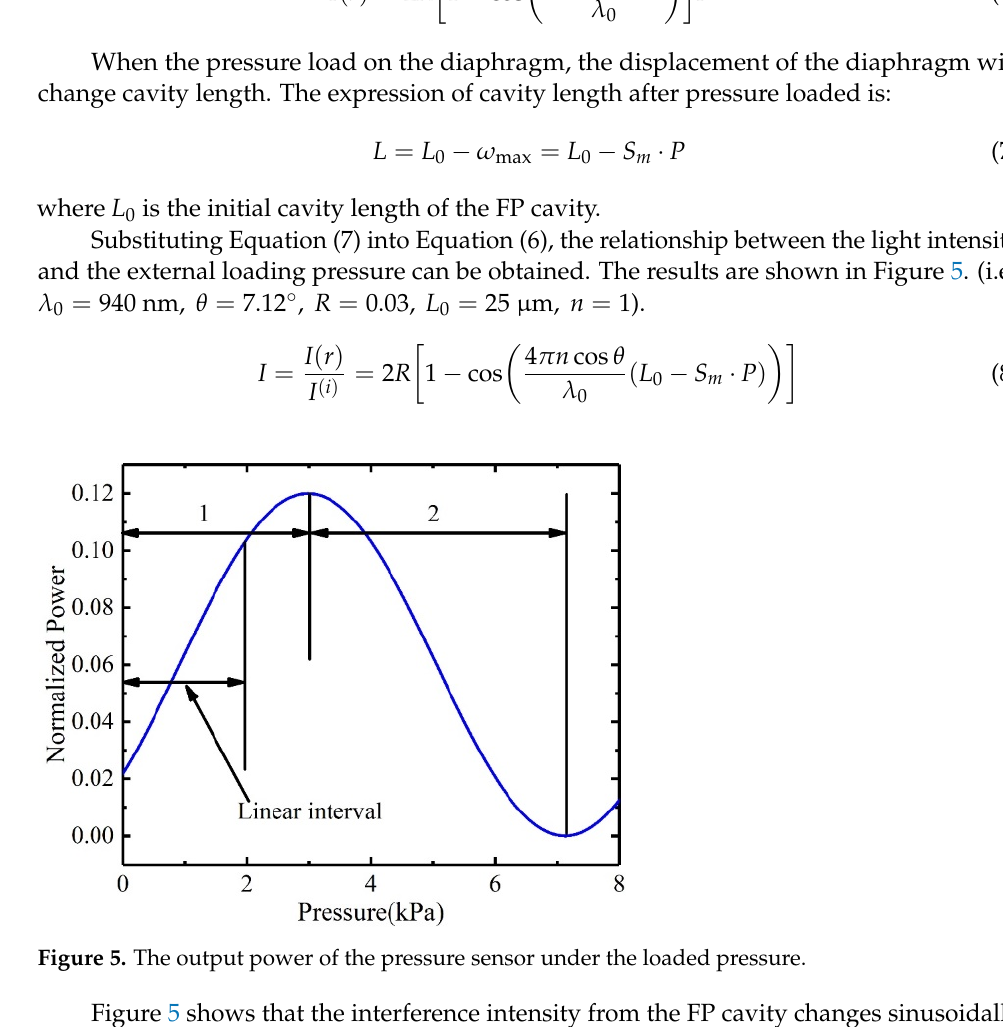
Figure 5. The output power of the pressure sensor under the loaded pressure. Figure 5 shows that the interference intensity from the FP cavity changes sinusoidally with the increase of external loading pressure. The effective working range of the pressure sensor is half the period of the sine curve, otherwise which the same output value will correspond to different loaded pressures. The working range of the pressure sensor can be interval 1, interval 2, or some other sub-sequent interval (e.g., when the initial loading pressure is 0 kPa, the working interval of the pressure sensor is interval 1; when the initial loading pressure is 6 kPa, and only the relative pressure value needs to be measured, the working range of the pressure sensor is interval 3). The maximum effective working range of the pressure sensor is 4.11 kPa. The pressure sensor works in the linear interval